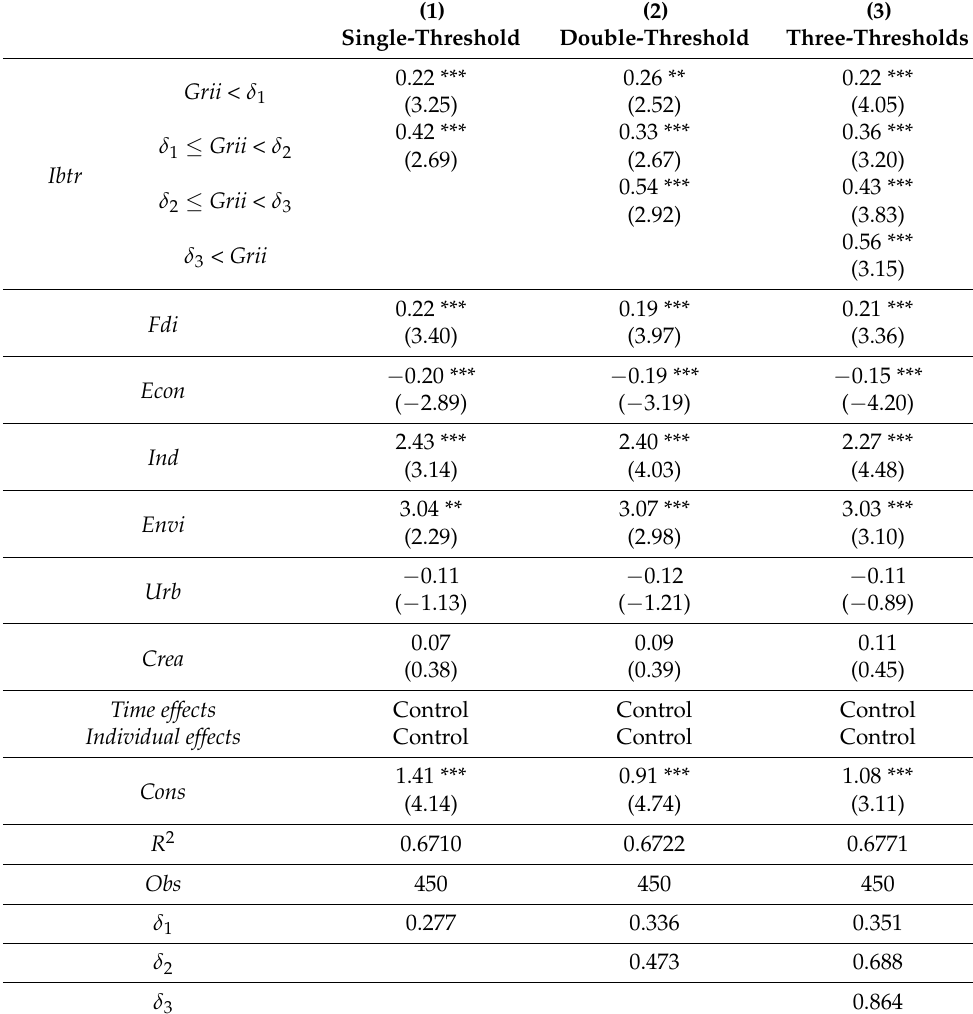
Table 8. Threshold effect results: From the perspective of green innovation